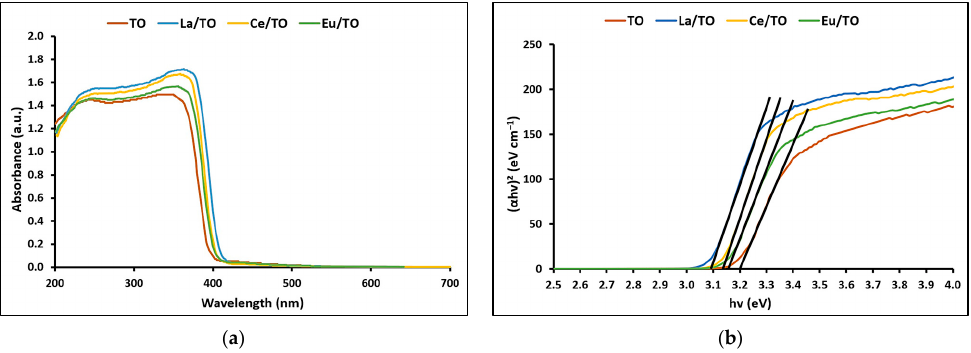
Figure 4. ( a ) UV–vis diffuse reflectance spectra and ( b ) plots of ( α hv) 2 vs. hv of TO, La/TO, Ce/TO, and Eu/TO